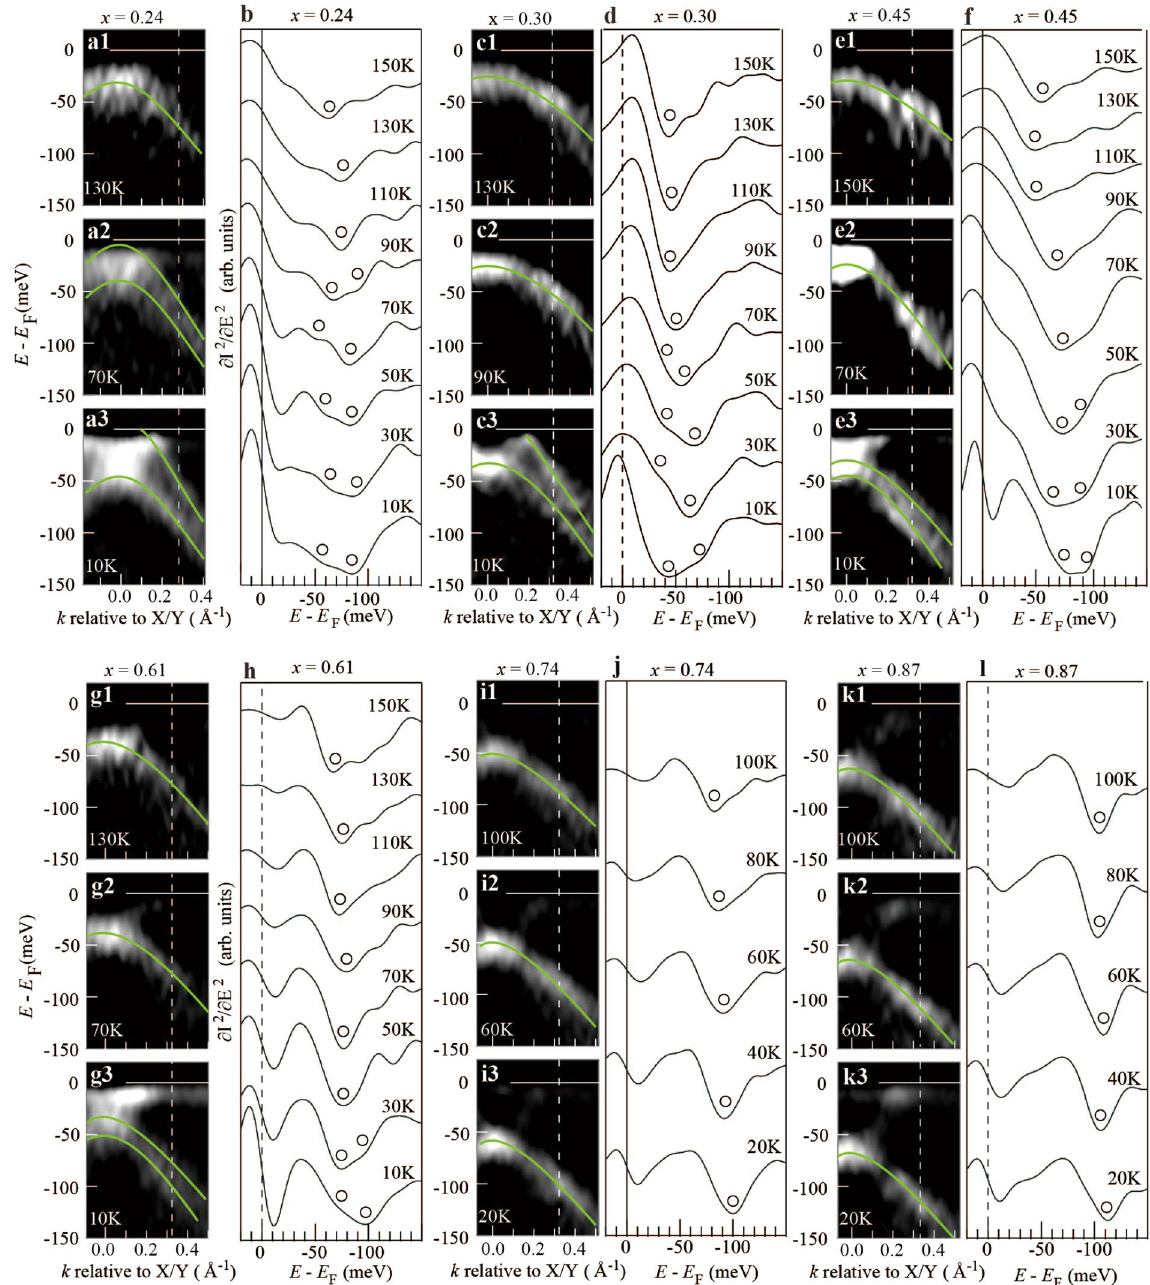
Figure 4. ( a1-a3 ) Second E derivative of the E-k images for x = 0.24 taken at 130 K, 70 K and 10 K, respectively. Green curves are the guides to the eyes. (b) T dependence of the second E derivative EDCs of twinned samples of x = 0.24 taken at the momentum indicated by the broken lines in (a1-a3). Black open circles represent the spectral dips corresponding to the energy position of δ hole bands. (c1-c3) The same as (a1-a3) but for x = 0.30. (d) The same as (b) but for x = 0.30. (e1–e3) The same as (a1–a3) but for x = 0.45. (f) The same as (b) but for x = 0.45. (g1–g3) The same as (a1-a3) but for x = 0.61. (h) , The same as (b) but for x = 0.61. (i1-i3) The same as (a1-a3) but for x = 0.74. (j) The same as (b) but for x = 0.74. (k1–k3) The same as (a1-a3) but for x = 0.87. (l) The same as (b) but for x =